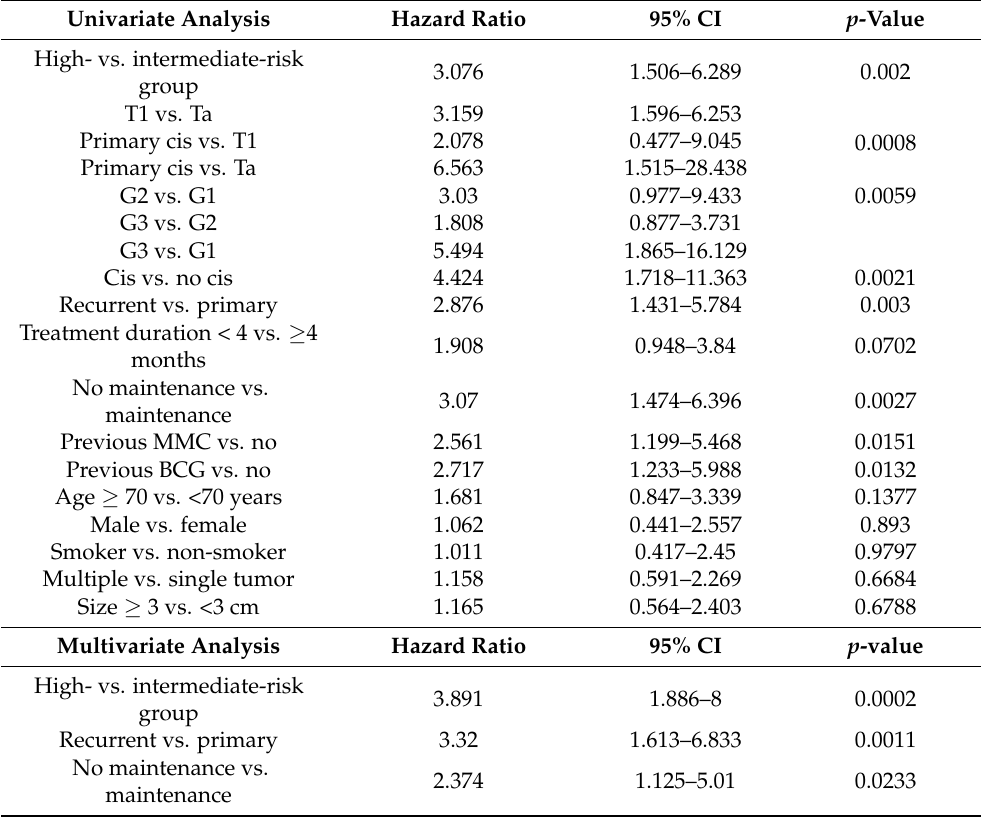
Table 4. Cox regression model to predict tumor progression, FAS population ( n =